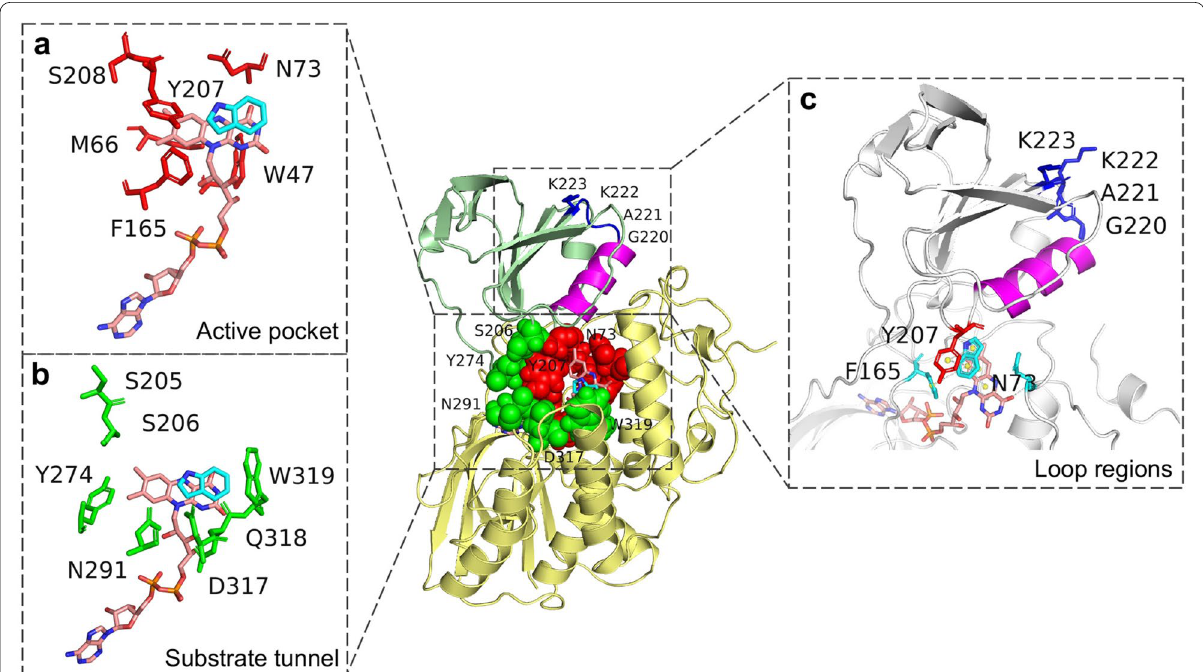
Fig. 2 Docking analysis of bFMO–indole complex, showing the location of active pocket residues (red), substrate tunnel residues (green) and the loop (blue) connected the α4 helix (purple), which have been targeted for mutagenesis. The FAD‑binding domain (residues 1–164 and residues 276–445) is shown in yellow; the NADPH‑binding domain (residues 165–275) is shown in green. The residues of the substrate tunnel (green) and the active pocket (red) are represented as spheres. The cofactors FAD (orange) and substrate indole (cyan) are represented as sticks. a Six residues located at active pocket within 8 Å with the indole, shown in red sticks. b Seven residues located at substrate tunnel, shown in green sticks. c Loop (residues 220–223, blue) connected with the α4 helix (purple). The π–π stacking interaction in the active pocket of bFMO, as shown in yellow